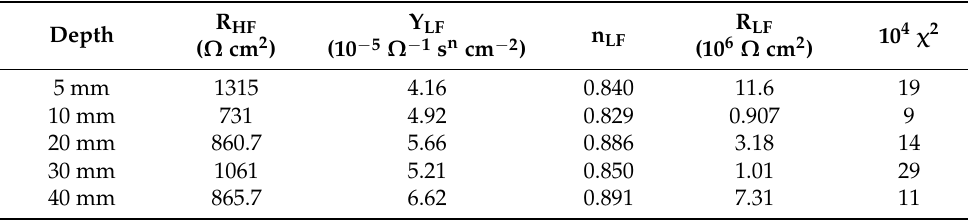
Table 2. Parameters obtained from the impedance spectra in Figure